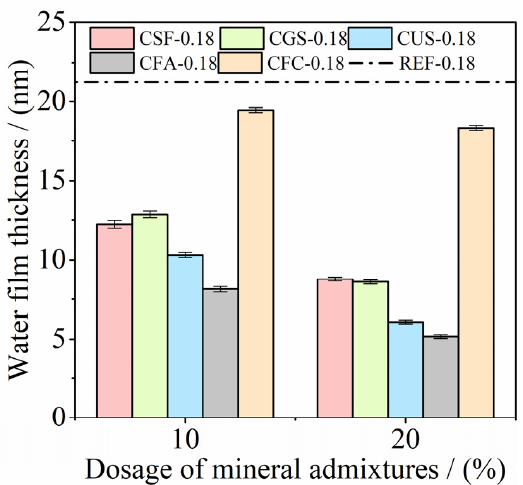
Figure 14. The water film thickness of UHPC-based pastes.